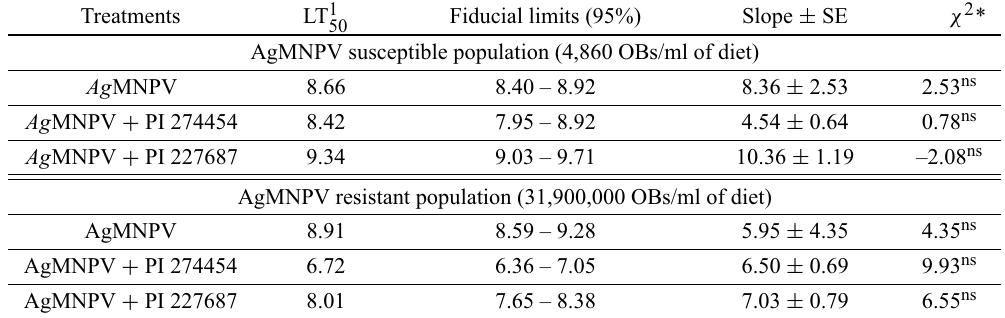
Median lethal times (LT 50 s), fiducial limits (95%), slope ( ± SE) and qui-square (χ 2 ) of AgMNPV susceptible and resistant populations of Anticarsia gemmatalis fed on a soybean extract diet (PI 274454 and PI 227687) or on a plain diet (C) and different concentrations of Ag MNPV. Treatments LT 1